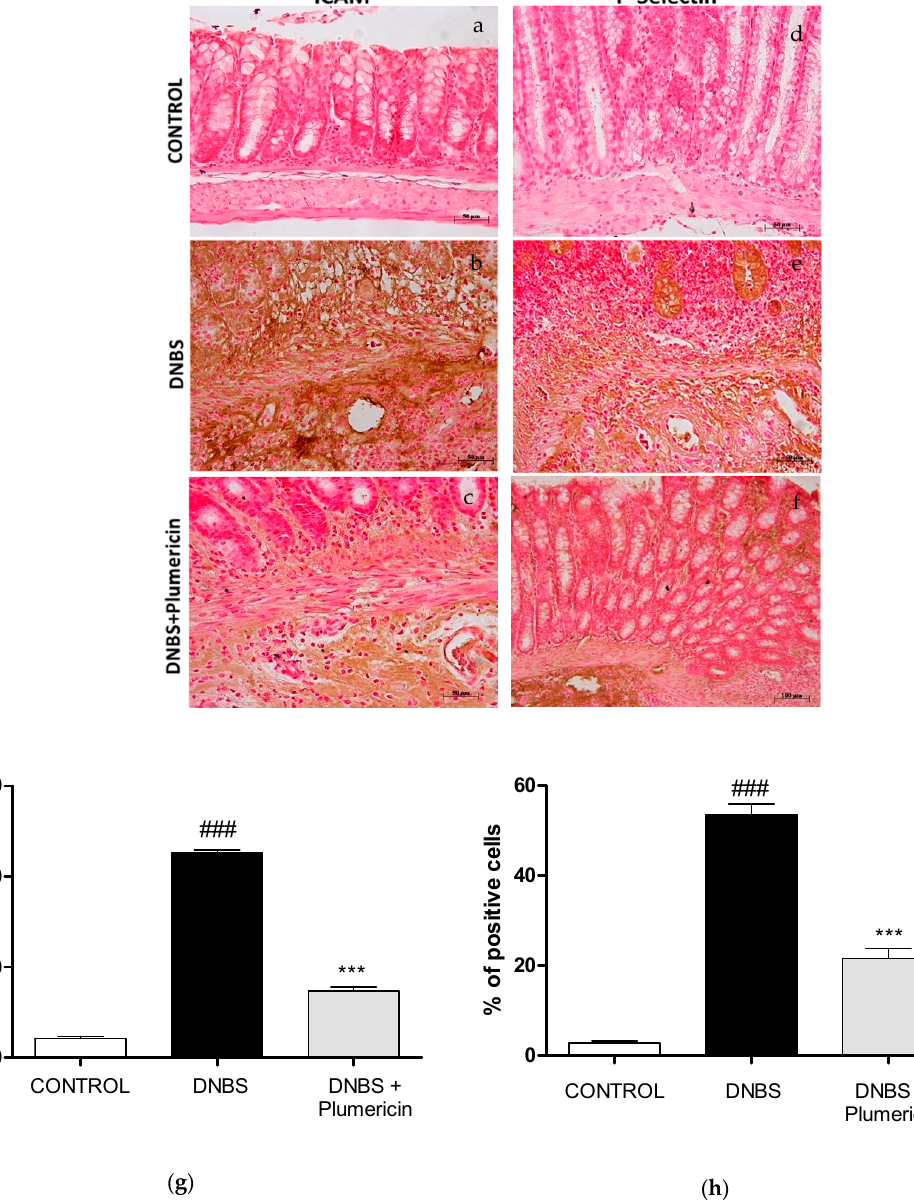
Figure 5. Effect of plumericin on ICAM-1 ( a – c ) and P-selectin ( d – f ) expression. ( g , h ) represent, respectively, densitometric analysis expressed as percentage of total tissue area. Photographs are representative of all animals in each group and data are means ± S.E.M. of 10 mice for each group. ### denotes p < 0.001 vs. control; *** denotes p < 0.001 vs. DNBS.